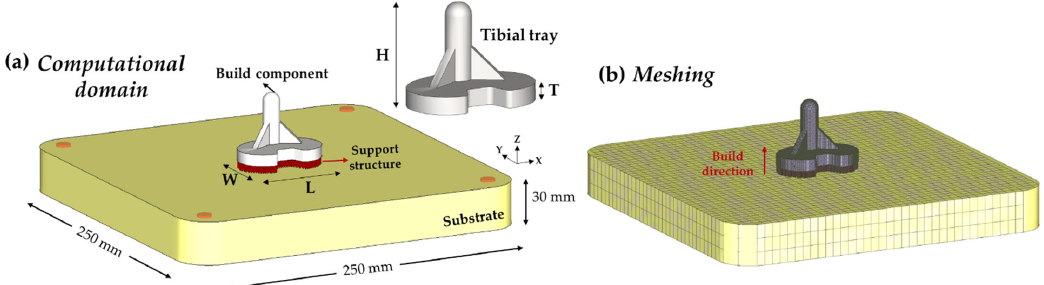
Figure 2. ( a ) Computational domain; ( b ) meshing.